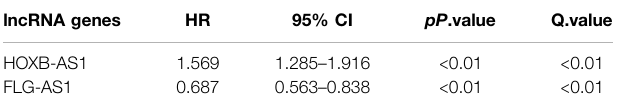
TABLE 4 | Validation of the survival signature for HOXB-AS1 and FLG-AS1 within the CGGA dataset. Down regulation was the reference state. lncRNA